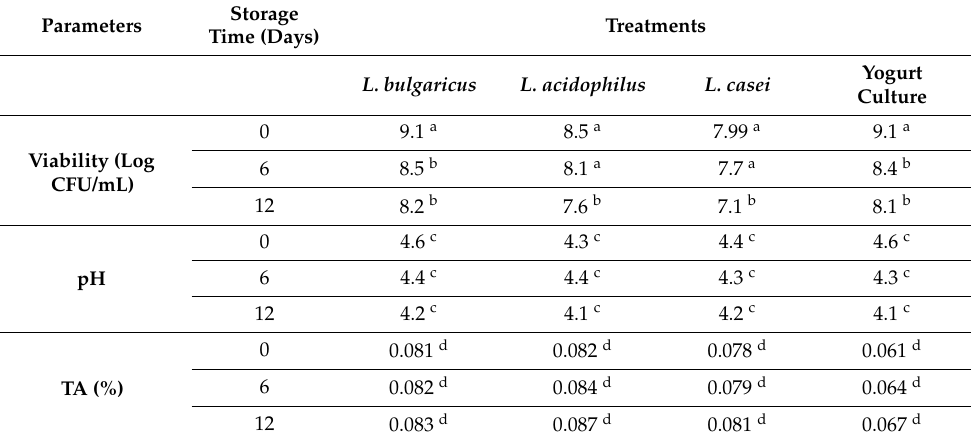
Table 3. Viable cell count, pH, and titratable acidity for fermented rice yogurt during storage at 5 ◦ C for 12